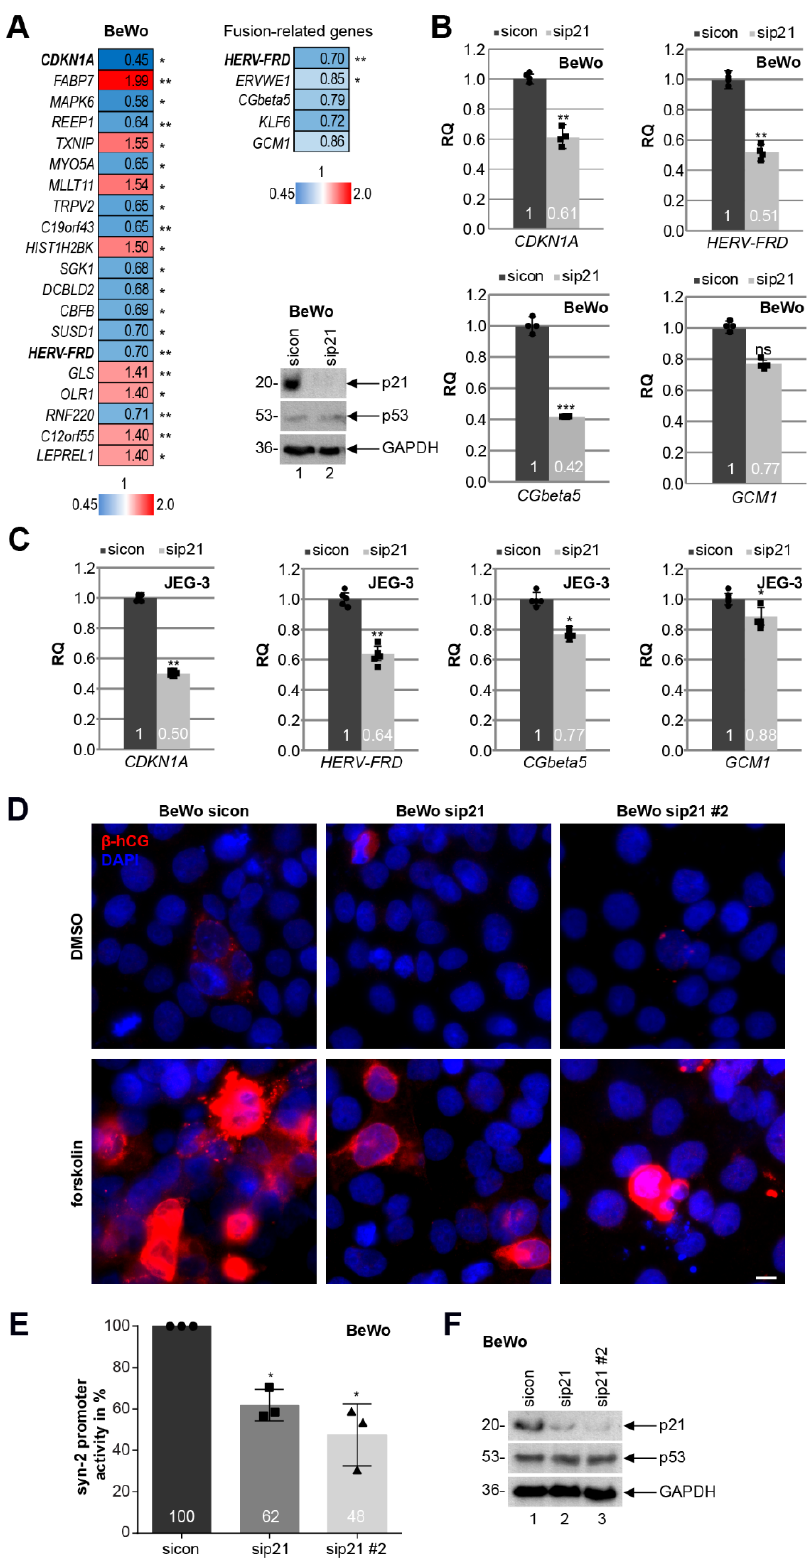
Figure 6. Knockdown of p21 impairs the fusion ability of BeWo and JEG-3 cells. ( A ) Left panel: genome-wide profiling of BeWo cells treated with sicon or sip21 for 48 h. Total RNAs were extracted from three independent experiments. Gene expression was analyzed using HumanHT-12 v4 bead- chip array. Genes with a p -value < 0.05 are included. Heatmap of the most differently expressed genes are shown (greater than 1, red color code; below 1, blue color code). Right upper panel: heatmap of fusion-related genes is depicted. Right lower panel: western blot analysis was per- formed with cellular lysates from BeWo cells treated with scrambled siRNA (sicon) or siRNA tar- geting the untranslated region (UTR) of p21 (sip21). GAPDH was taken as the loading control. ( B )